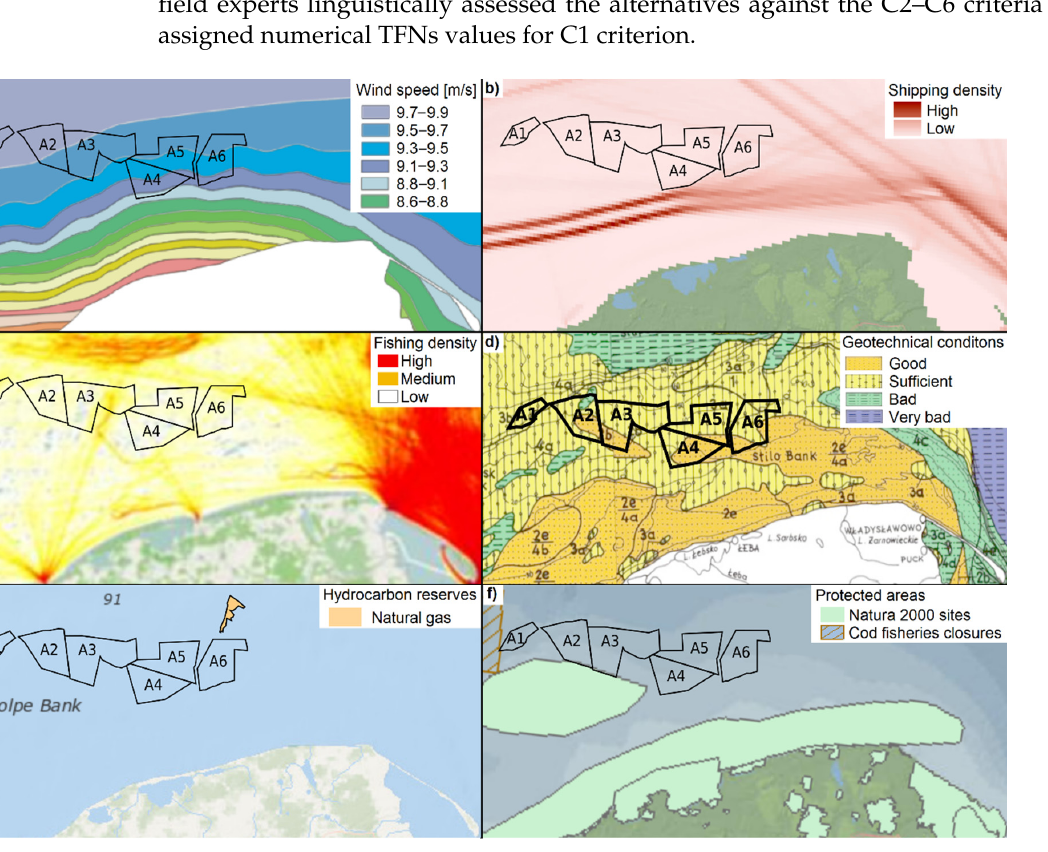
Table 2. Criteria weights assigned by individual stakeholders.